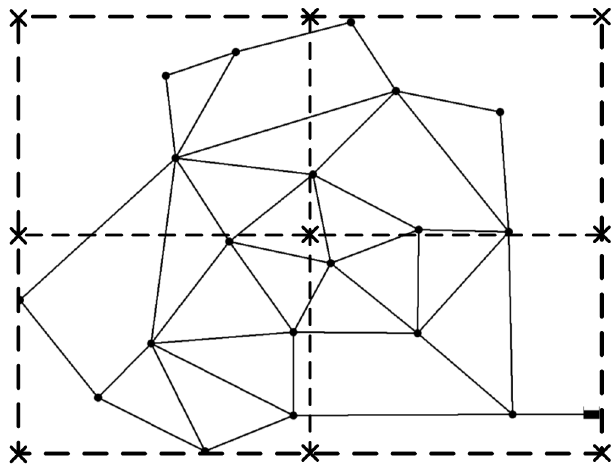
Figure 3. Study network layout (epicenter is marked as “x”).